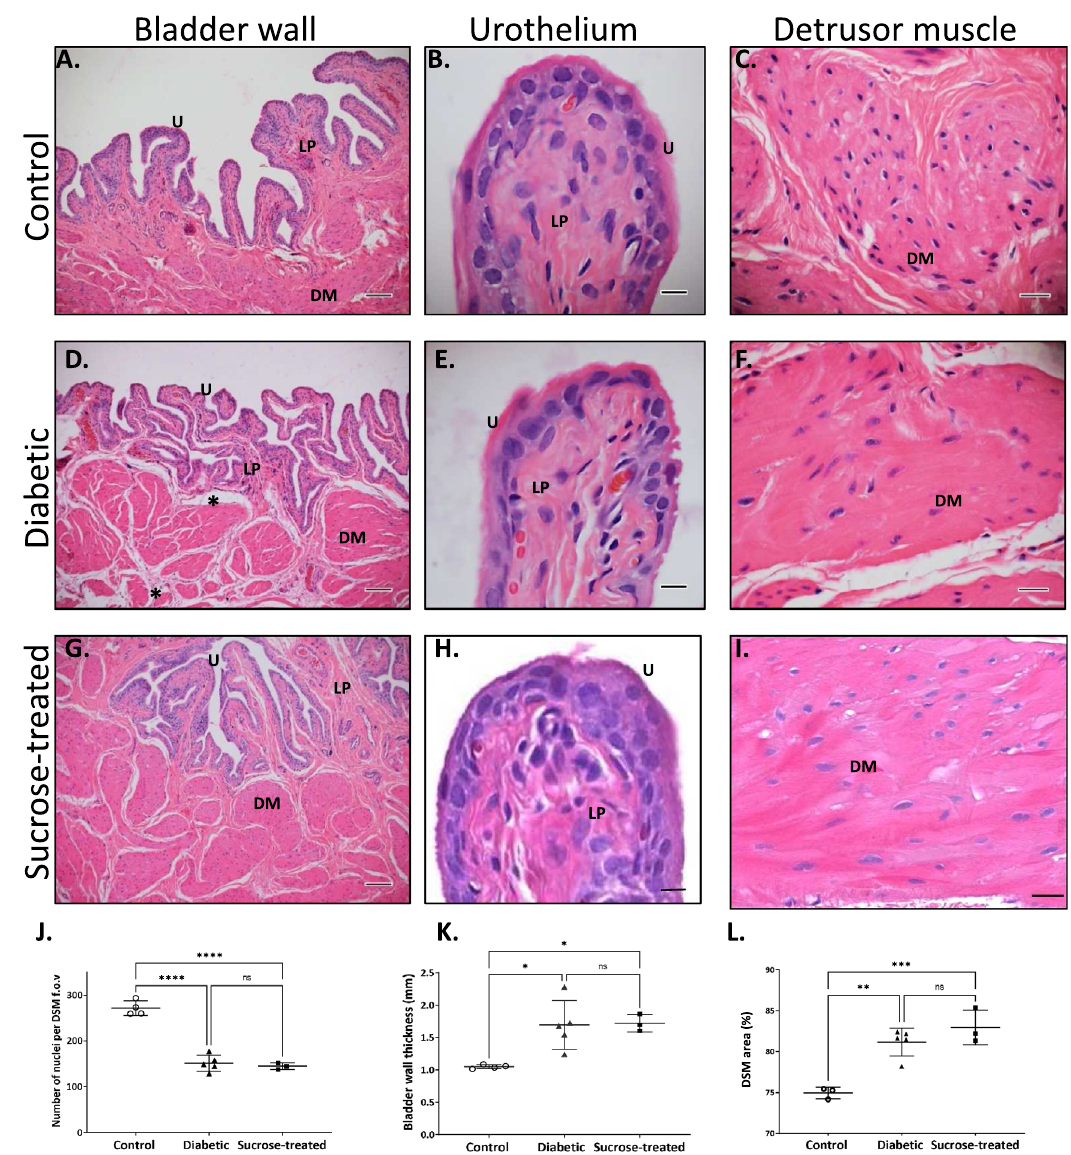
Figure 2. Histological characterisation of the urinary bladder of control, diabetic and sucrose-treated rats. Representative hematoxylin and eosin stained transverse sections taken from the equatorial region of urinary bladders from ( A – C ) control, ( D – F ) diabetic and ( G – I ) sucrose-treated rats after 16 weeks. Hypertrophy occurred in DSM ( F , I ) of both diabetic ( n = 5) and sucrose-treated rats ( n = 3), with fewer visible nuclei per region of DSM ( J ), thickening of the bladder wall ( K ) compared to controls ( n = 4). The relative area occupancy of DSM in the bladder wall increased similarly in both diabetic and sucrose-treated groups ( L ). Expanded unstained regions around DSM bundles of diabetic rats are also noted (asterisks, D ). u = urothelium; LP = lamina propria; DM = detrusor muscle; Scale bars ( A , D , and G ) = 100 μm; ( B , E , and H ) = 10 μm; ( C , F , and I ) = 20 μm. Data are expressed mean ± SD analysed by one way ANOVA followed by Tukey’s post hoc test (* p < 0.05; **** p <